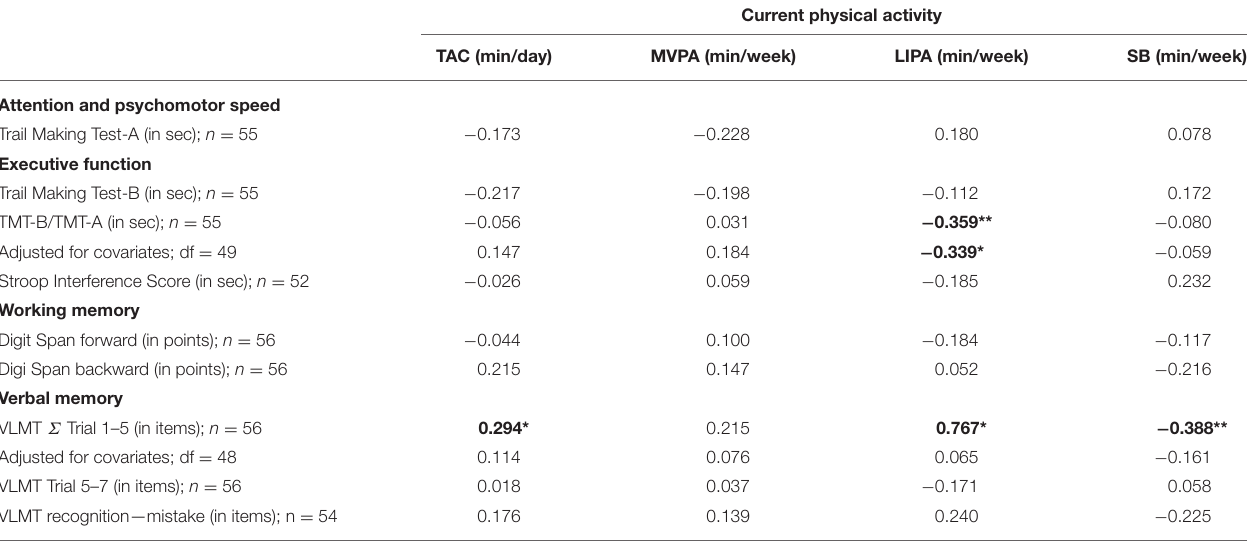
TABLE 2 | Bivariate Spearman and partial correlations between cognitive performance and current physical